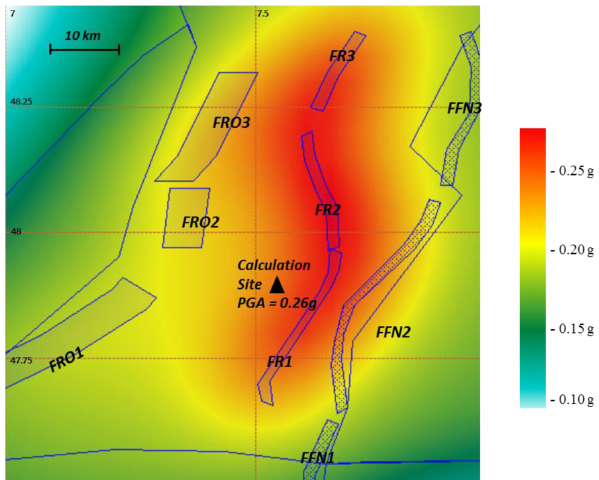
Figure 3. PGA seismic hazard map at a return period of 10000 years for the reference logic tree branch: active Rhine River fault, seismogenic depth of 15km, steepest dip for the faults, low slip rate values for the faults, Gutenberg–Richter MFD and the CB08 GMPE. Polygons represent the fault projections at the sur- face of the modelled faults (hachured polygons indicate the faults sources that are considered inactive in this calculation). Contours of the background area source are shown as well. Figure produced with the CRISIS2015 software, Ordaz et al. (2014). FR is Rhine River fault, FFN is Black Forest fault and FRO is West Rhenish